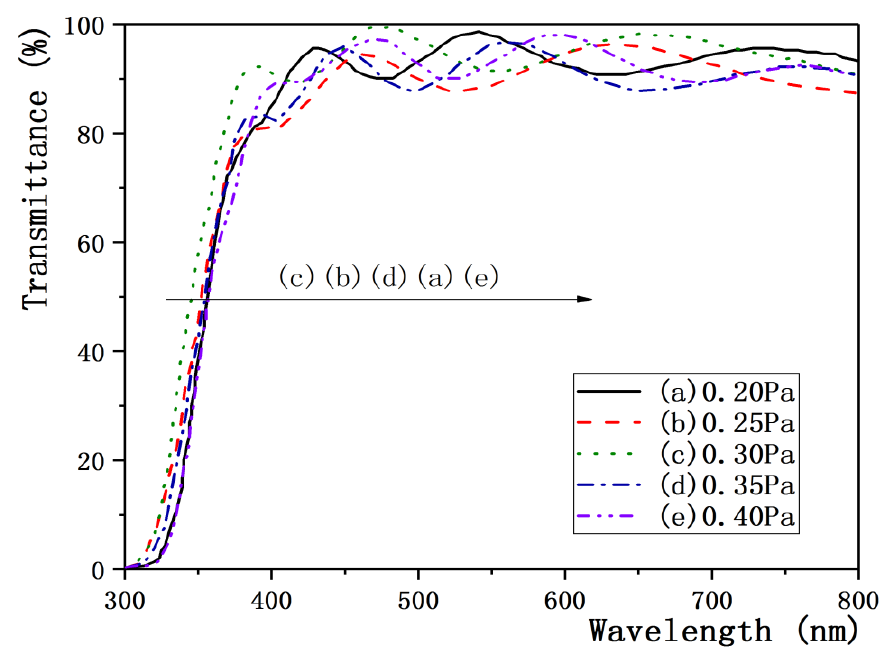
Figure 9. Transmission spectra of ZnO:Ga films prepared at different oxygen partial pressures [75]. The intensity of luminescence peak of ZnO:Ga scintillation films varies with the O 2 /Ar ratio, the chemical ratio of Zn to O in ZnO:Ga films depends on oxygen content, and the concentration of various intrinsic defects in the films is also affected by oxygen content [107]. Therefore, the emission spectrum of ZnO:Ga films is related to the ratio of Ar to O 2 and the defects concentration. Lin [96] reported that the relationship between intrinsic defects and oxygen partial pressure in ZnO:Ga thin film can be expressed by the chemical-like reaction equation below.